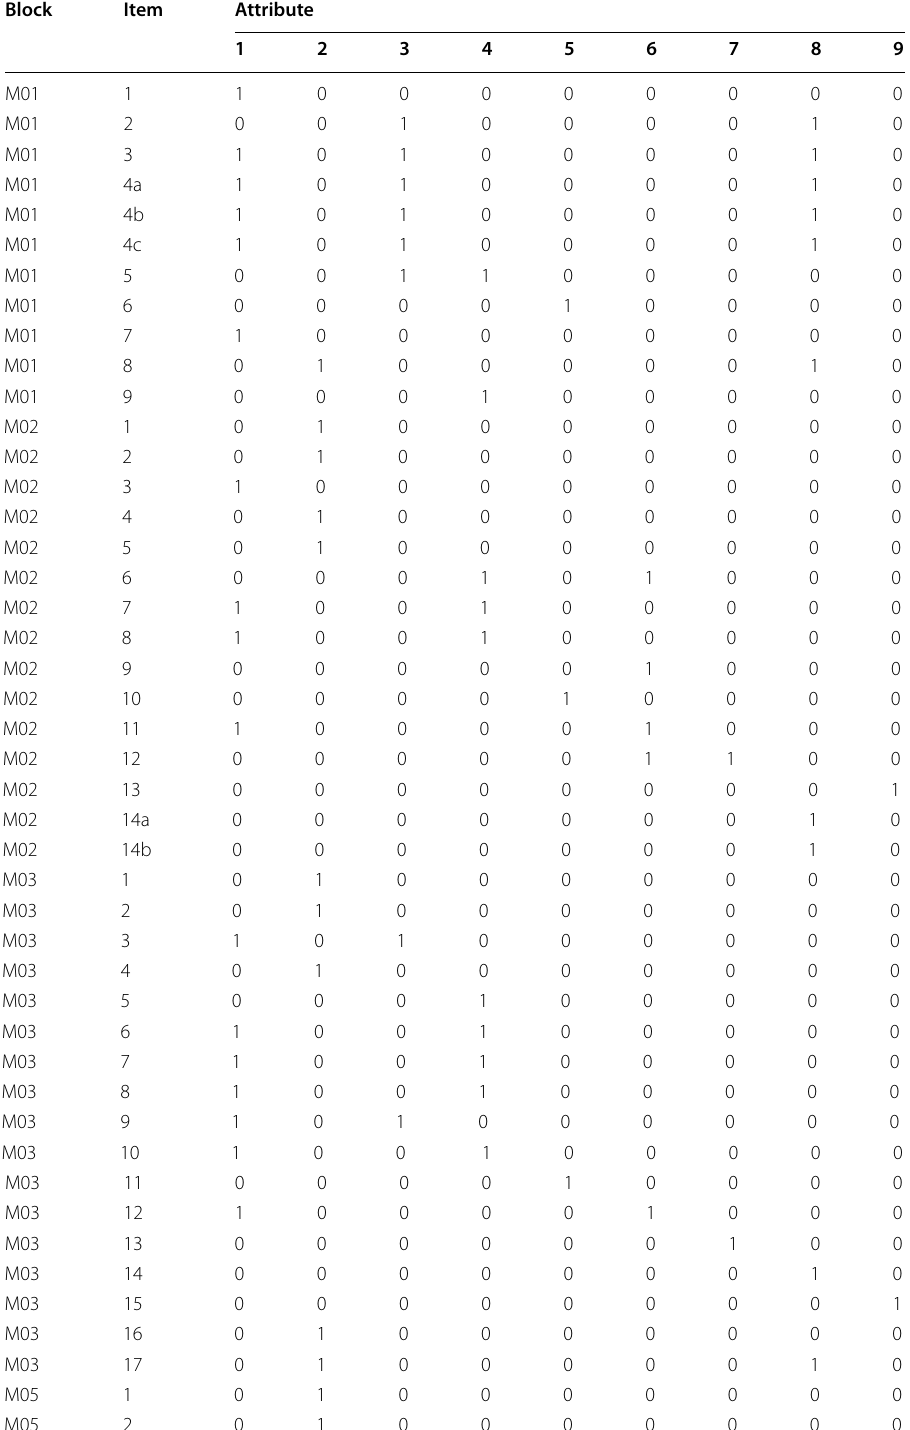
Table 8 Q-matrix designed by experts for 89 Items of TIMSS 2011 8th grade mathematics